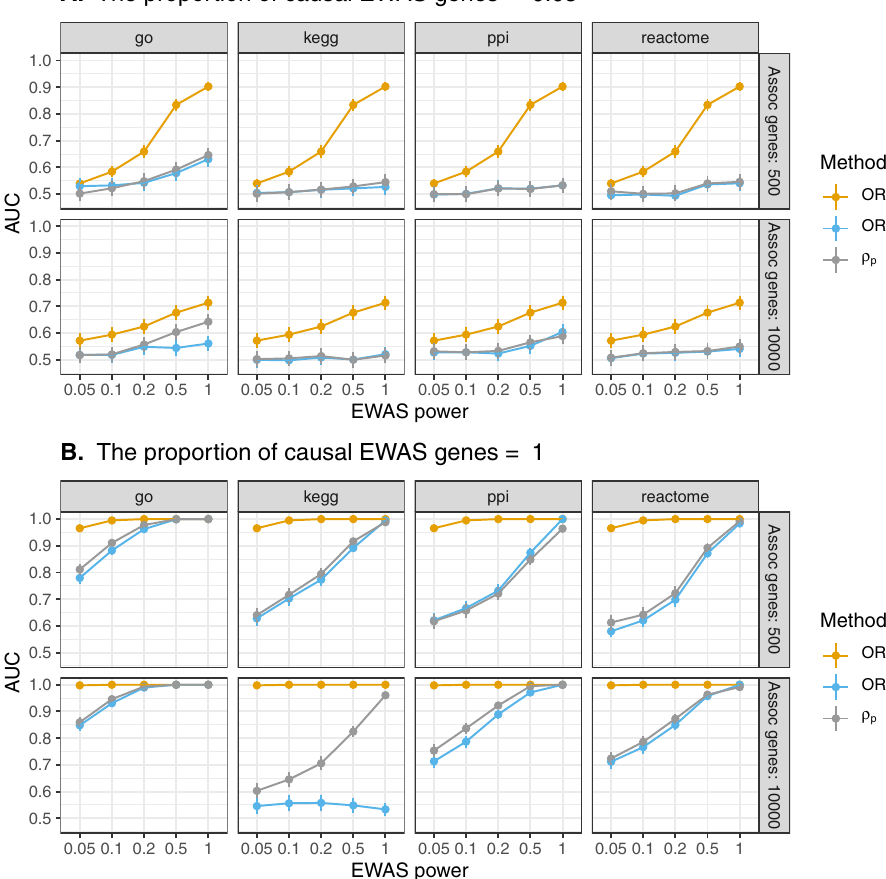
Fig. 3 | Power to detect overlap between genes and genesets identi fi ed by corresponding GWAS and EWAS. Simulations were set up as illustrated in Box 1 and simulations iterated over each set of parameters 1000 times. EWAS power is equivalent to the proportion of associated genes (Assoc genes) EWAS is detecting. In the scenario where Assoc genes = 500, EWAS power = 1, and the proportion of causalEWASgenes=0.05,theEWASisdetecting500genes,25ofwhicharecausal. Panel A show results when the proportion of causal EWAS genes = 0.05 and panel B show results when the proportion of causal EWAS genes = 1. The area under receiver operator curves (AUC) was used to estimate the ability to distinguish